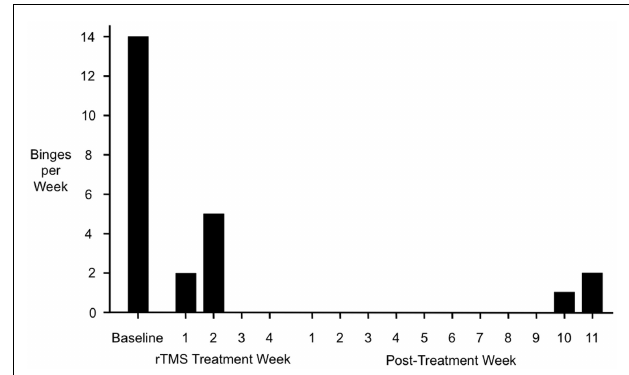
FIGURE 1 | Binge-purge episode incidence before, during, and after rTMS of the DMPFC. Full remission from binge-purge episodes was achieved by the third week of treatment, and was sustained for 9weeks after the completion of treatment. Note that the treatment and post-treatment periods are separated purely for schematic reasons in this figure; in terms of temporal sequence, post-treatment week 1 immediately followed rTMS treatment week 4 with no intervening